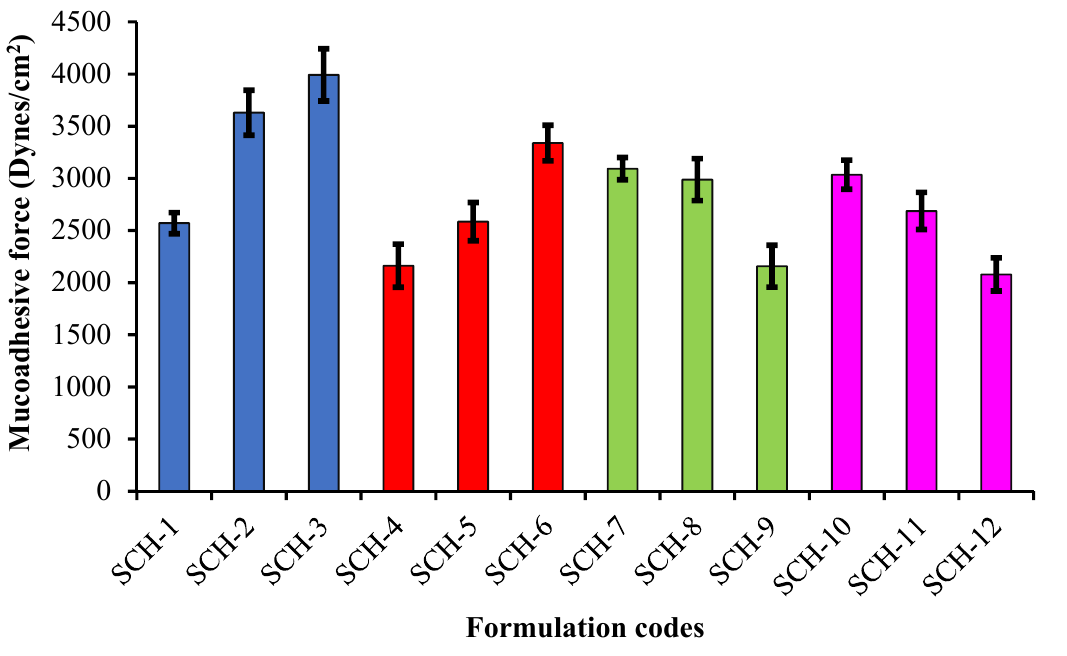
Figure 12. Comparison of the Mucoadhesive force (Dynes/cm 2 ) of developed formulations (SCH-1 to SCH-12) ( p -value > 0.05).